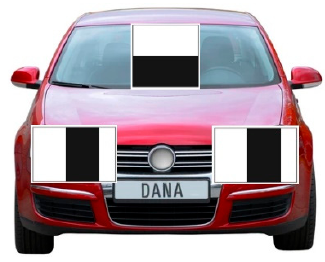
Figure 5. Haar features on vehicle image.